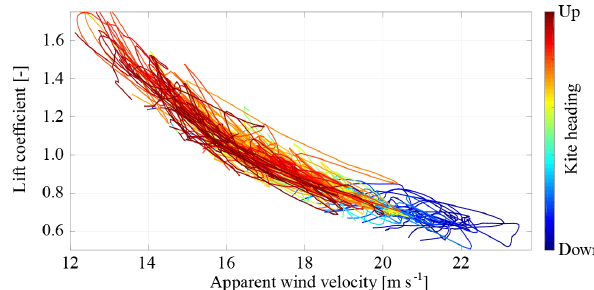
Figure 18. Measured lift coefficient C L of the kite as a function of the relative flow velocity v a and colored by the heading. The heading range from down to up covers both heading angle ranges 180 ◦ > ψ > 0 ◦ and 180 ◦ < ψ < 360 ◦ equally (see Fig.